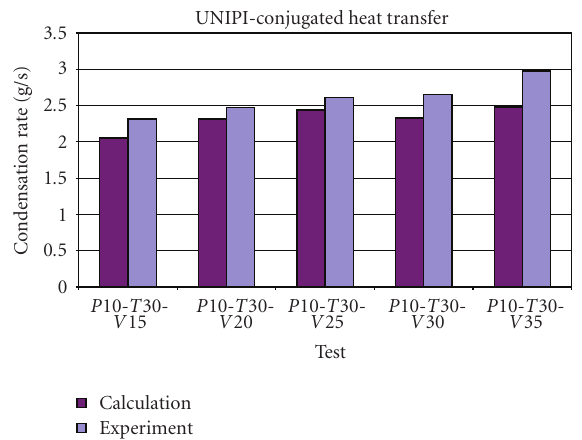
Figure 14: Results for the overall condensation rate obtained by the University of Pisa in the Condensation Benchmark Step-1.